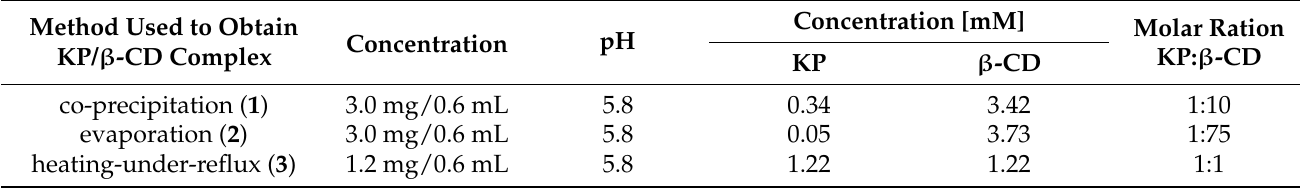
Table 3. The concentration and molar ratio of KP and β -cyclodextrin ( β -CD) in the tested aqueous solutions of powder samples obtained by three methods.